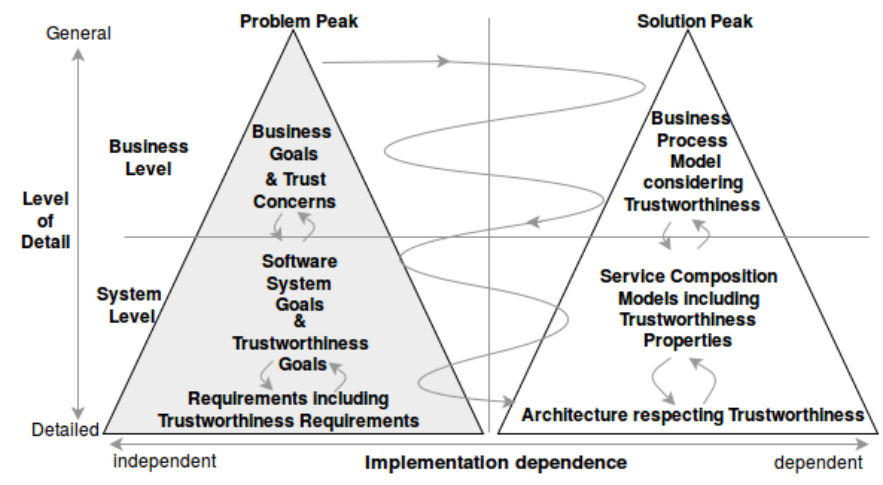
Figure 1. Overview of the proposed framework inspired by